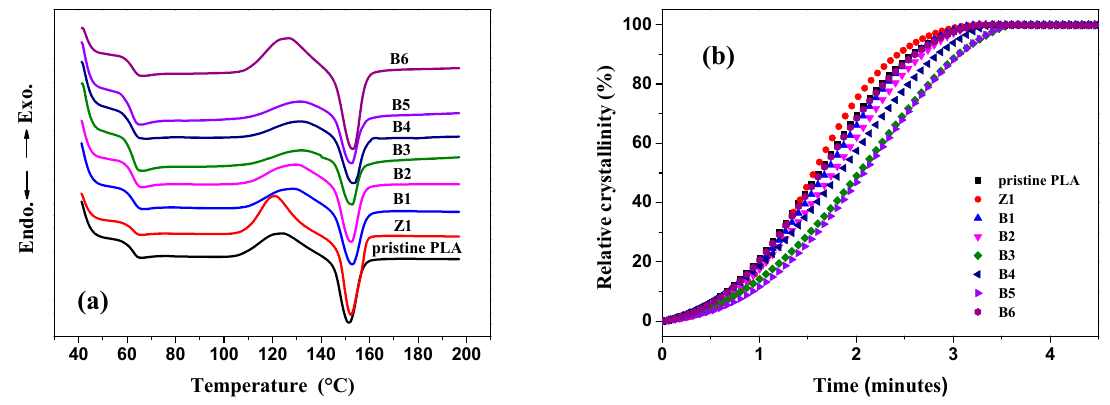
Figure 14. ( a ) DSC second heating curves and ( b ) relative cold crystallinity versus time of PLA samples at a heating rate of 10 °C·min − 1 . Table 3. Second heating crystallization parameters of samples at a 10 °C·min − 1 heating rate.